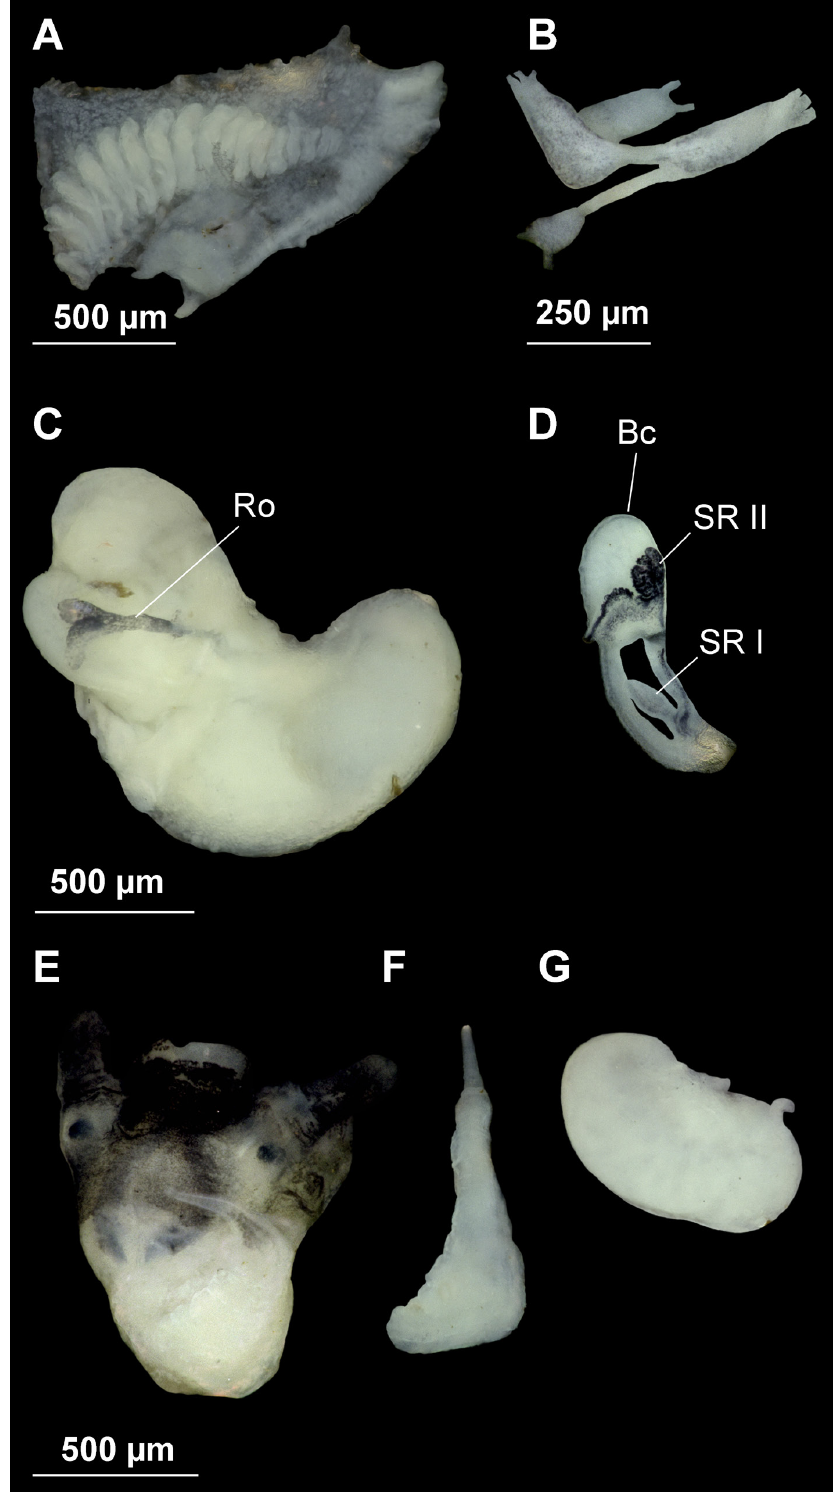
Fig. 9. Anatomy of Shadinia terpoghassiani (Shadin, 1952) from Lake Aiger-Lich, Armenia. A . Ctenidium and osphradium. B . Partial nervous system. C . Female genitalia. D . Bursa copulatrix and seminal receptacle. E–F . Head of a male and penis. G . Prostate gland. Anatomical abbreviations given in the Material and methods